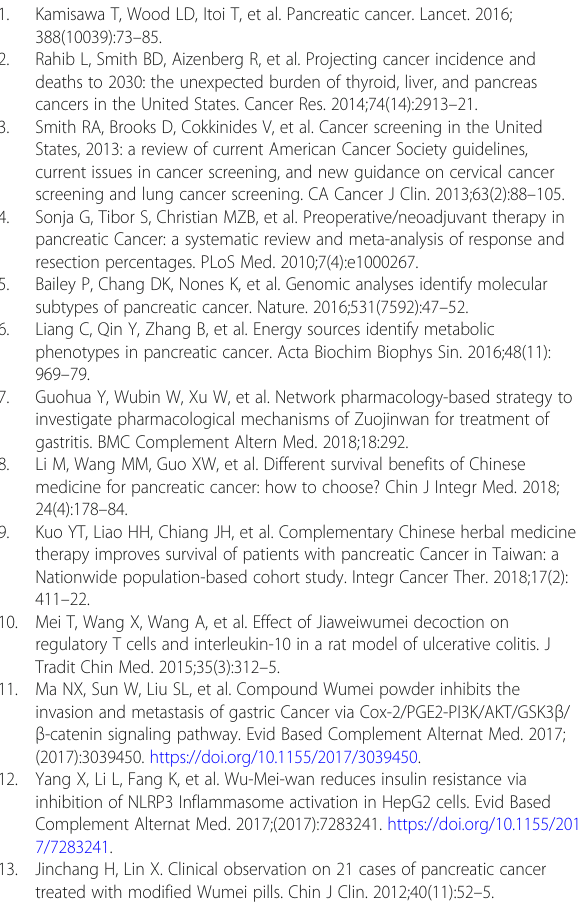
Abbreviations ACS: American Cancer Society; DG: Radix Angelicae Sinensis; DL: Drug- likeness; FDR: False discovery rate; FZ: Radix Aconiti Lateralis